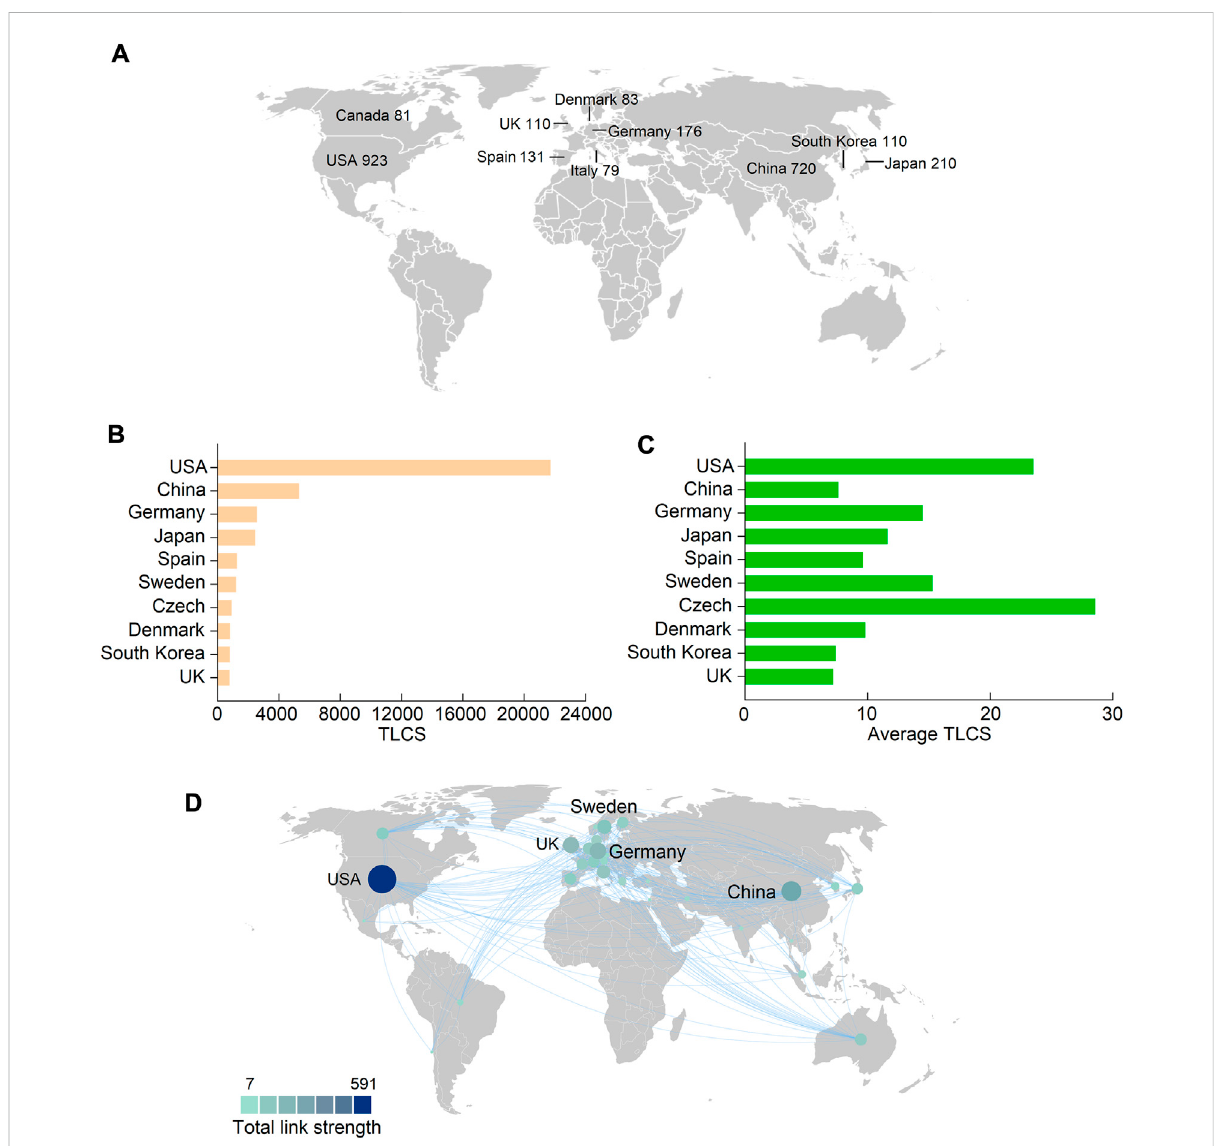
FIGURE 2 Leading countriesinthe fi eldofFGF-21research. (A) Thetop tenproductivecountriesconcerningFGF-21. (BandC) TLCSandaverageTLCSof the top ten countries with the highest TLCS. (D) The international collaboration among different countries. Each country is represented as a node, and each line means a co-authorship relationship. The node size is proportional to the collaboration link